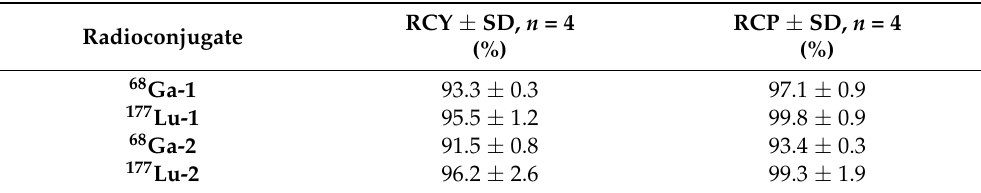
Table 2. Results of radiochemical yield and radiochemical purity of the synthesized 68 Ga-1 , 177 Lu-1 , 68 Ga-2 , and 177 Lu-2 radioconjugates.